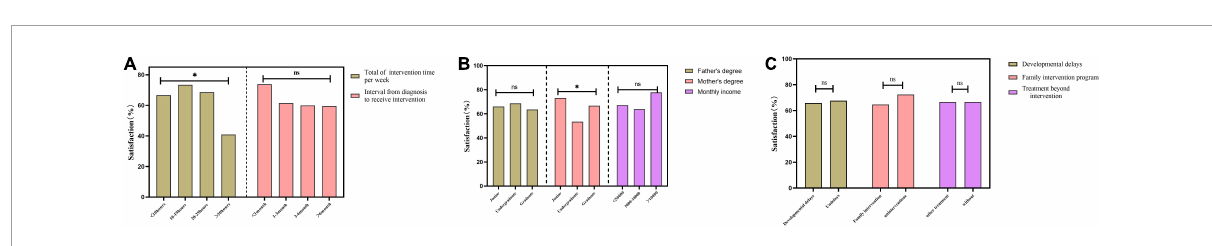
FIGURE2 Analysis of influencing factors of satisfaction with intervention treatment for children with Autism spectrum disorder (ASD). (A) For total intervention duration per week and interval from diagnosis to receiving intervention, (B) for parents’ degree and monthly income, and (C) for developmental delays, family intervention program, and treatment beyond intervention. * p < 0.05; ns, p > 0.05.